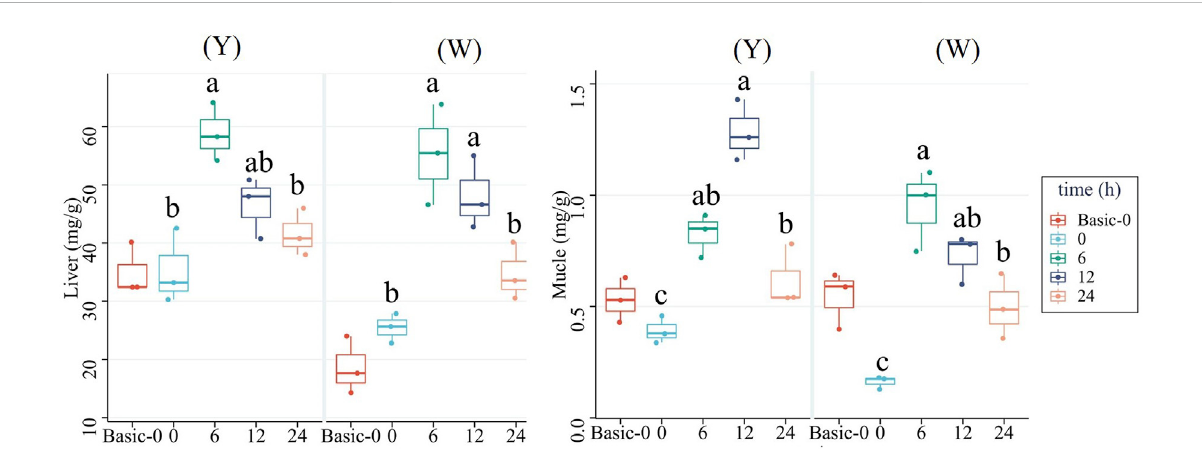
FIGURE 2 Glycogen contents inthe liverand muscle.Data are expressedas mean + SD ( n = 12). Different lettersindicate signi fi cant differences ( p <